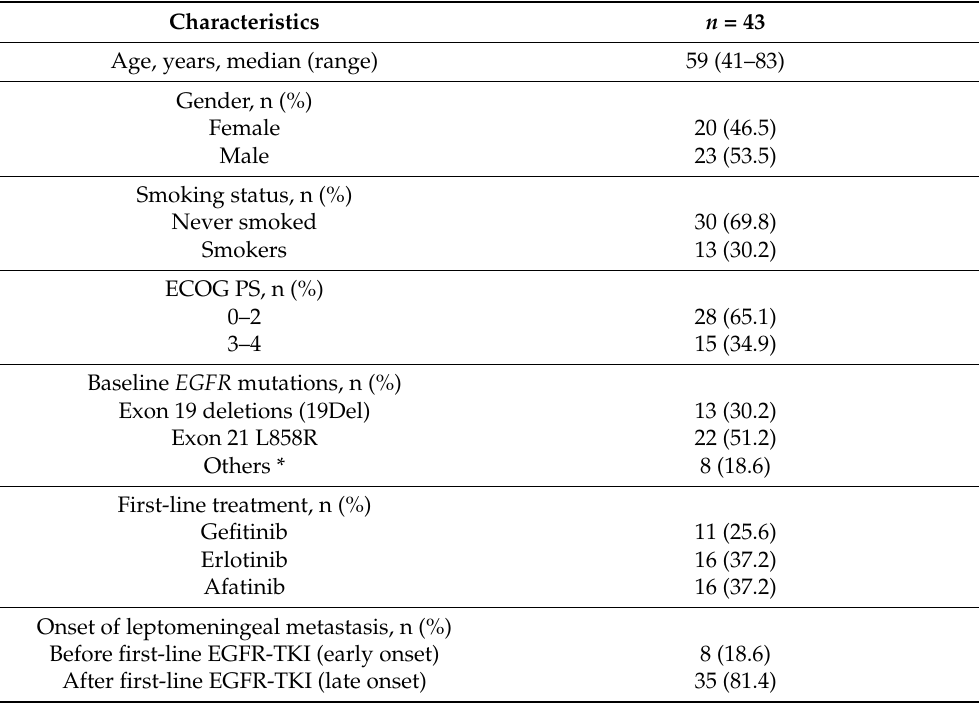
Table 1. Demographic data and patient